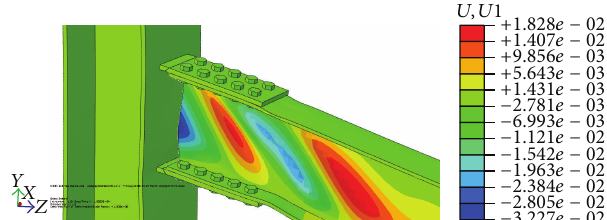
Figure 17: Out-of-plane buckling of the beam web for connection to the bolted cover plate.